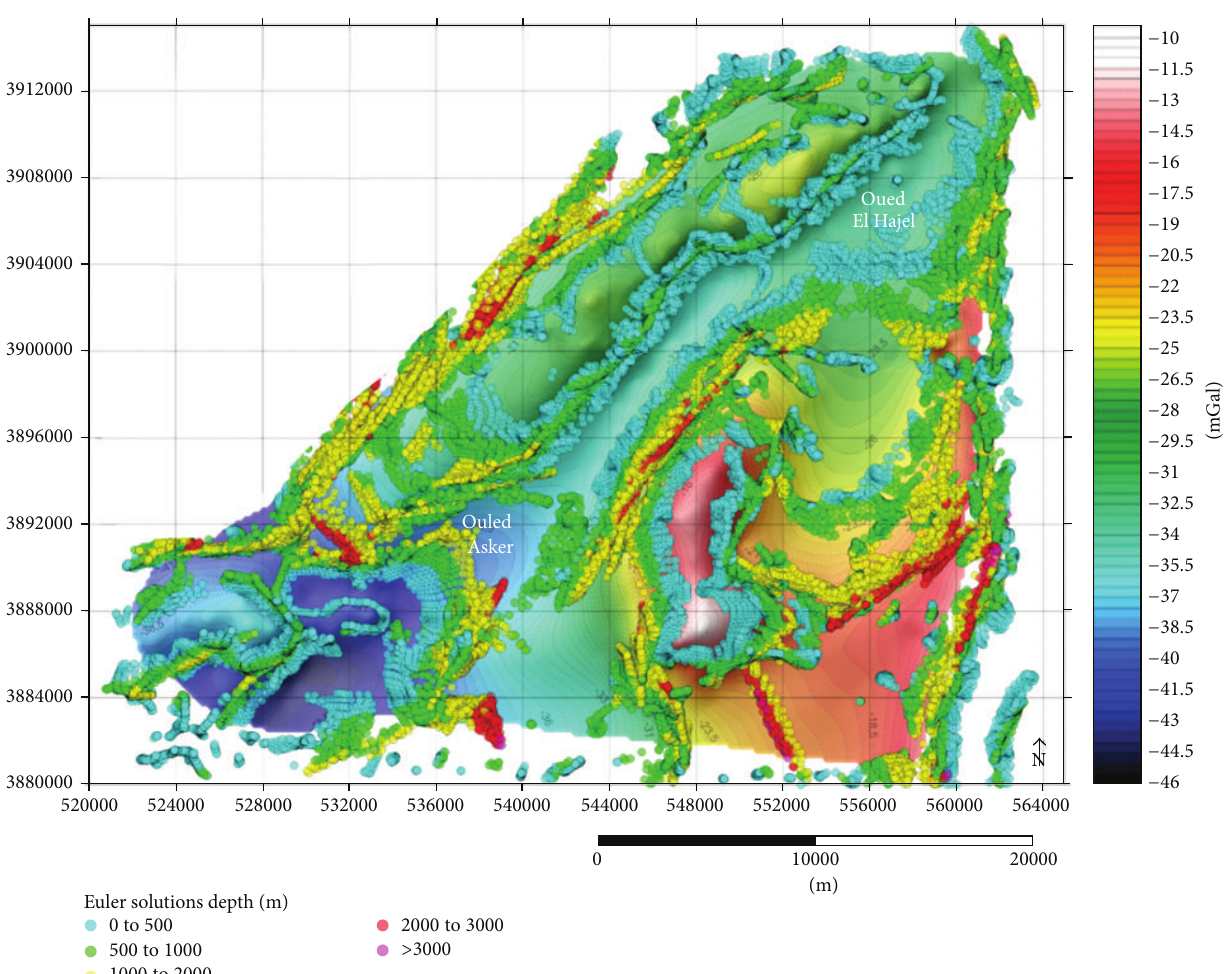
Figure 9: Euler solution to detect contact zone (structural index 0, window 10 ∗ 10, and error